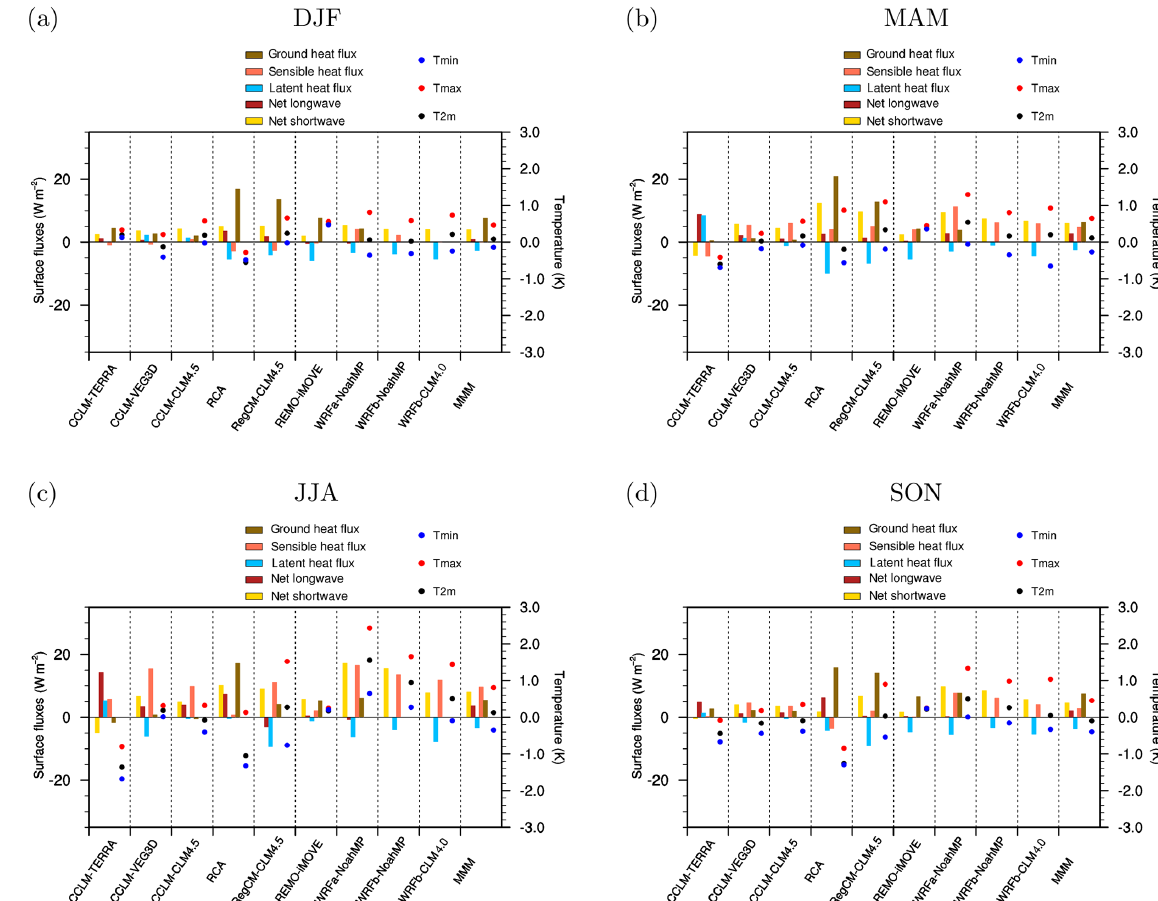
Figure 10. Changes in temperature and in surface energy balance components (FOREST minus GRASS) averaged over the Mediterranean for DJF, MAM, JJA and SON. Results for other regions are shown in the Supplement.